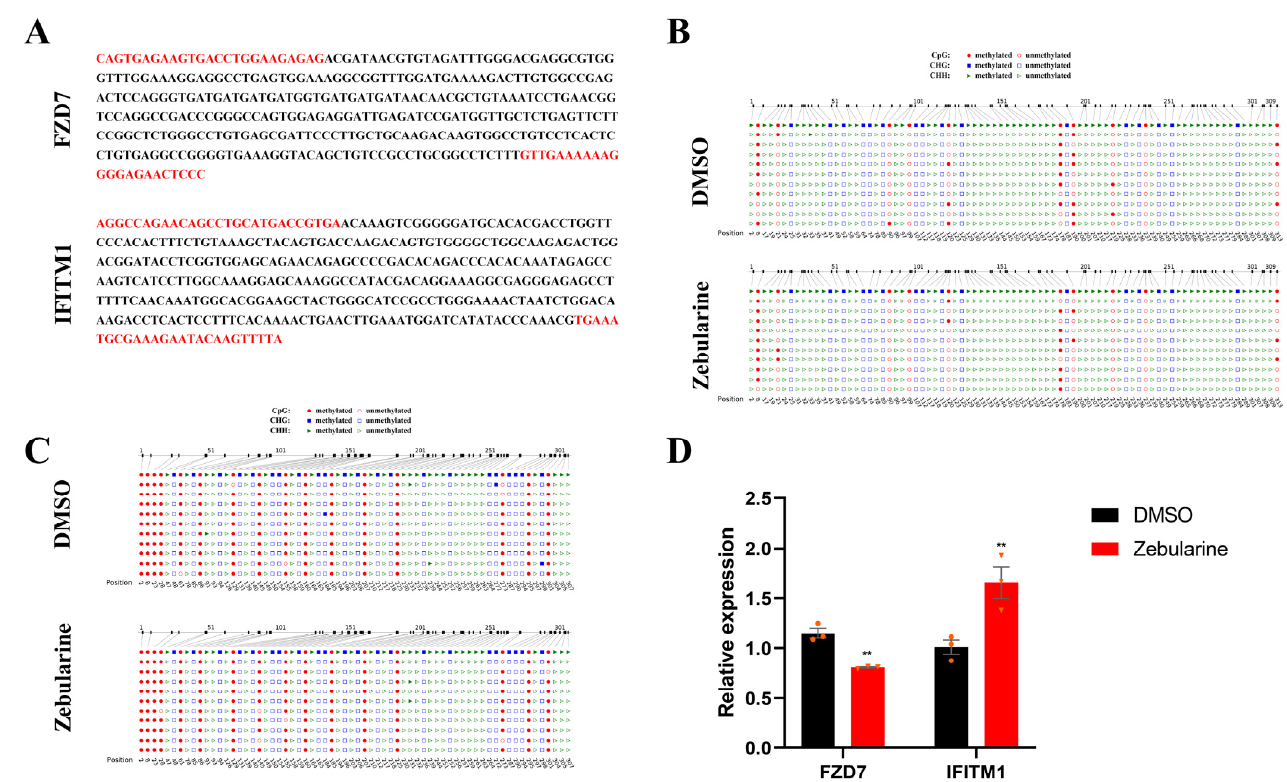
Figure 4. Results of zebularine treatment. ( A ) Target amplified sequences of FZD7 and IFITM1 for BSP. Bases marked in red are the primer positions. ( B , C ), Demethylation sites of FZD7 and IFITM1 , by treating with zebularine. ( D ) The relative mRNA levels of FZD7 and IFITM1 between two treatments. Orange triangles and circles represented the numerical distribution of three biological repeats in each group. Data are presented as the mean ± SEM. ** p < 0.01. Table 2. Percentage of methylated cytosines in the three types of contexts.